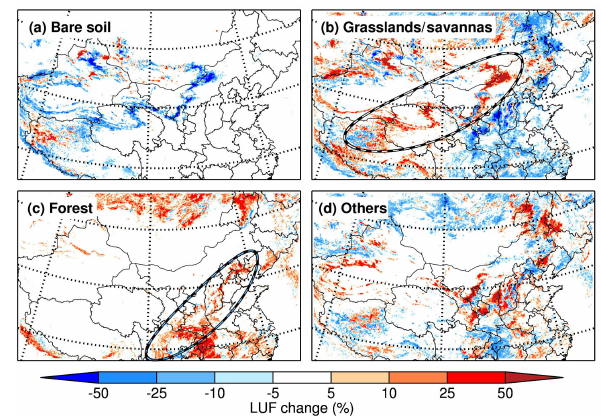
Figure 2. The horizontal distributions of land cover changes from 2001 to 2013 for the categories of (a) bare soil, (b) grass- lands/savannas, (c) forest, and (d)